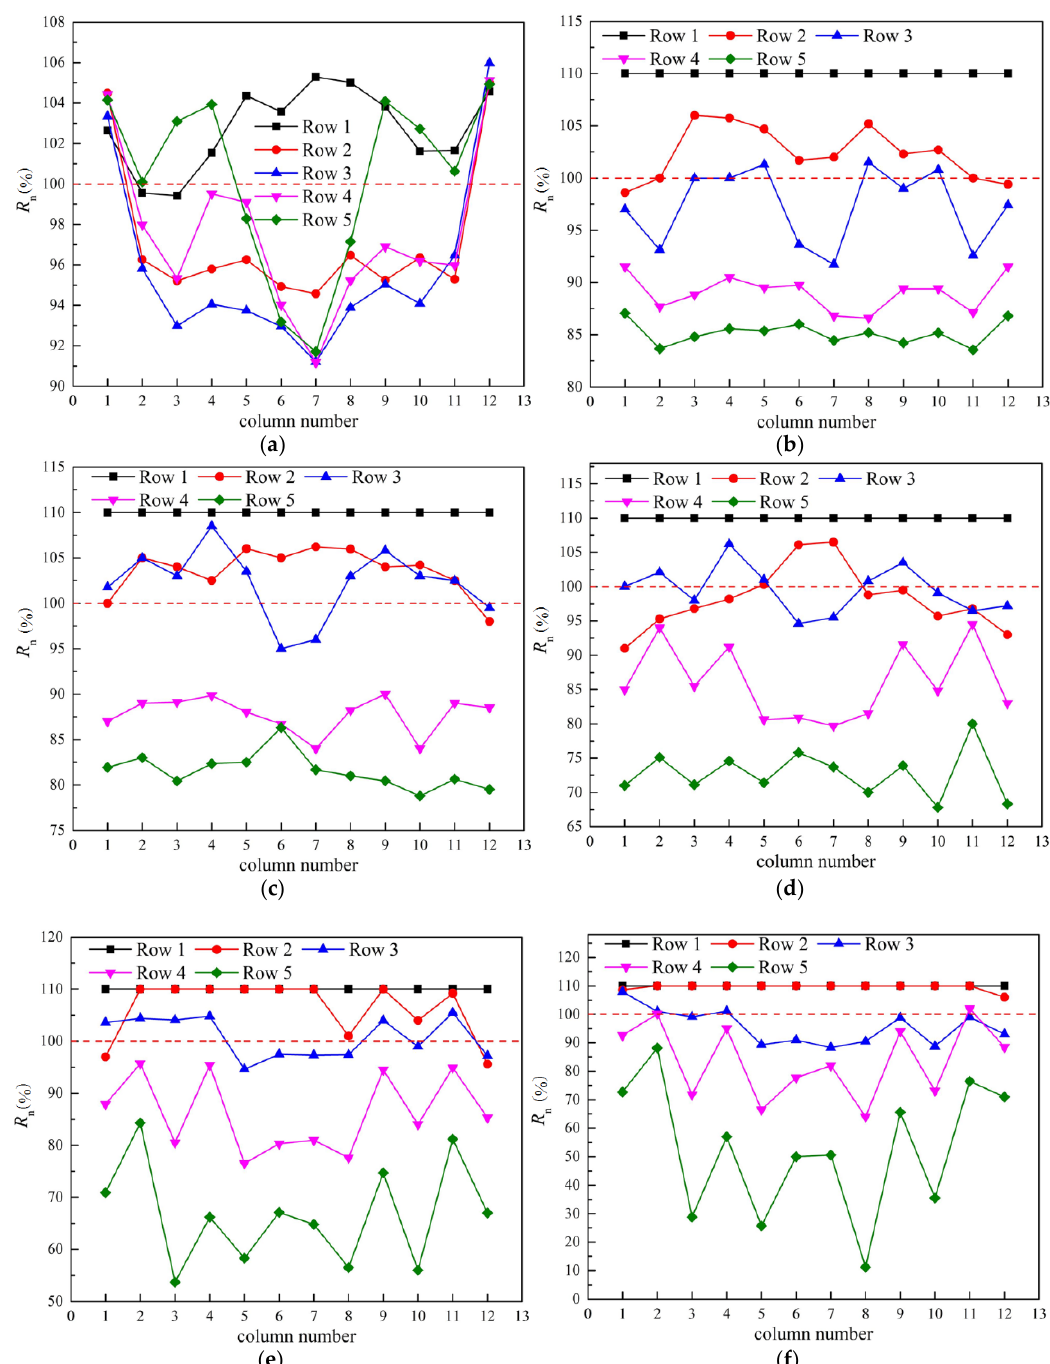
Figure 14. Rotational speed of each fan for Str-2 cases under various ambient conditions: ( a ) no wind; ( b ) 4 m/s; ( c ) 8 m/s; ( d ) 12 m/s; ( e ) 16 m/s; ( f ) 20 m/s. ( d ) 12 m/s; ( e ) 16 m/s; ( f ) 20